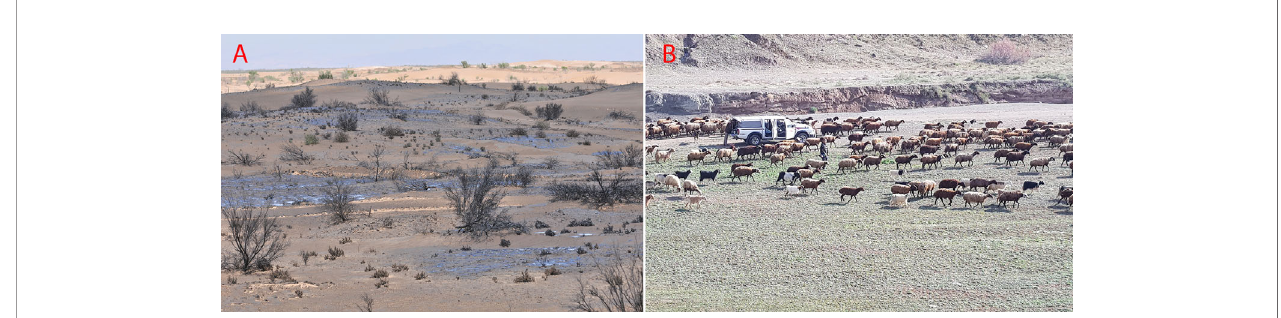
FIGURE 11 | (A, B) : Mismanagement of C 4 habitats in Iran. (A) Oil mulching in sand dunes with rich C 4 plant species in Abuzeidabad, Kashan, Central deserts of Iran, 28.5.2020. (B) Overgrazing in gypsum and salty ground between Zanjan and Mianeh, Northeast (NE) Iran, 14.4.2018. (Photos by H.